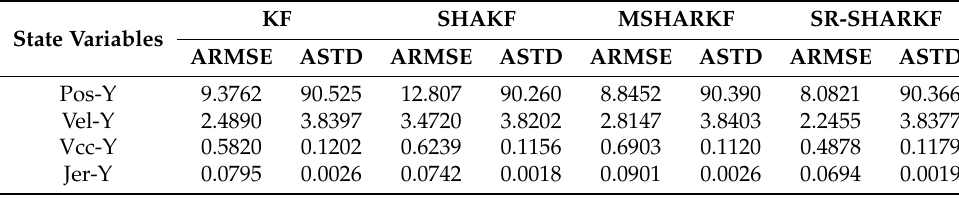
Table 6. Dynamic parameter ARMSE and ASTD evaluation in the Y-axis direction.